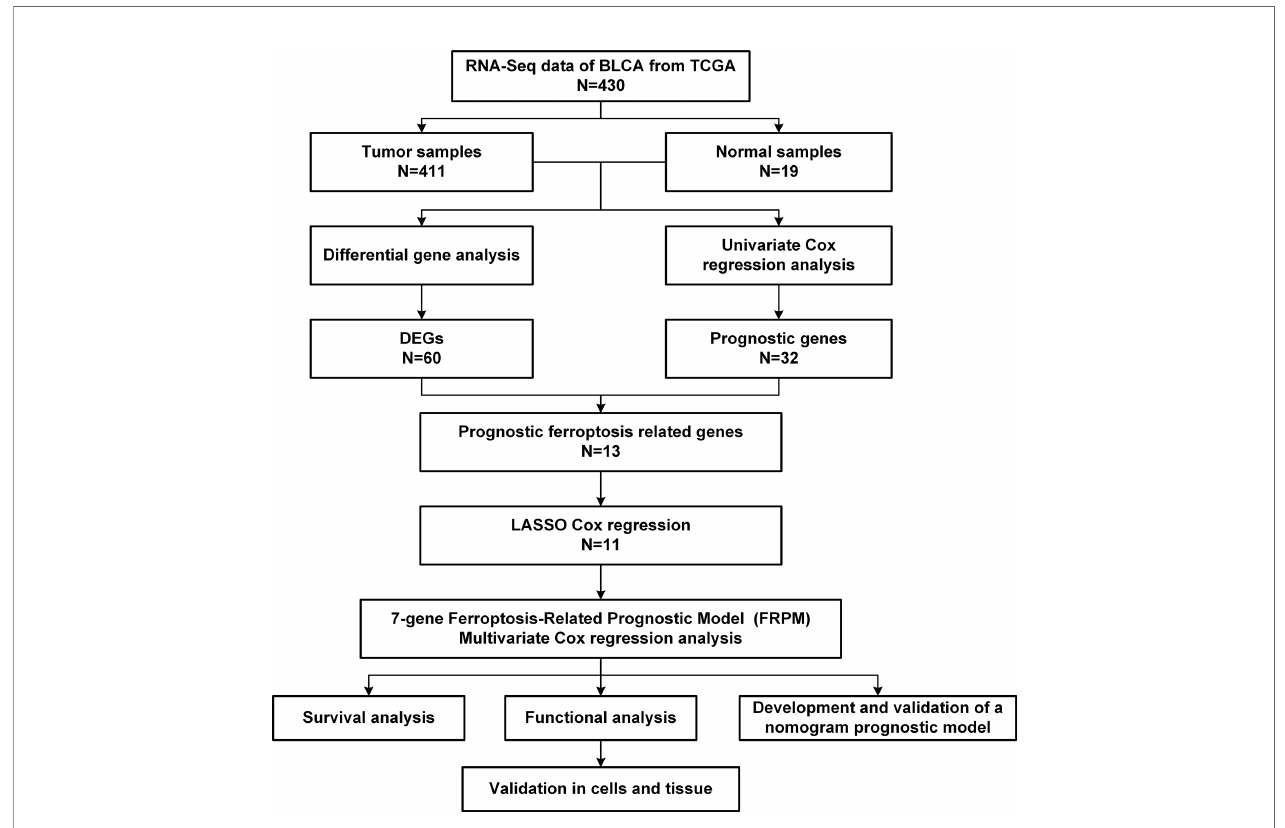
FIGURE 1 | Flow chart of the data collection and analysis